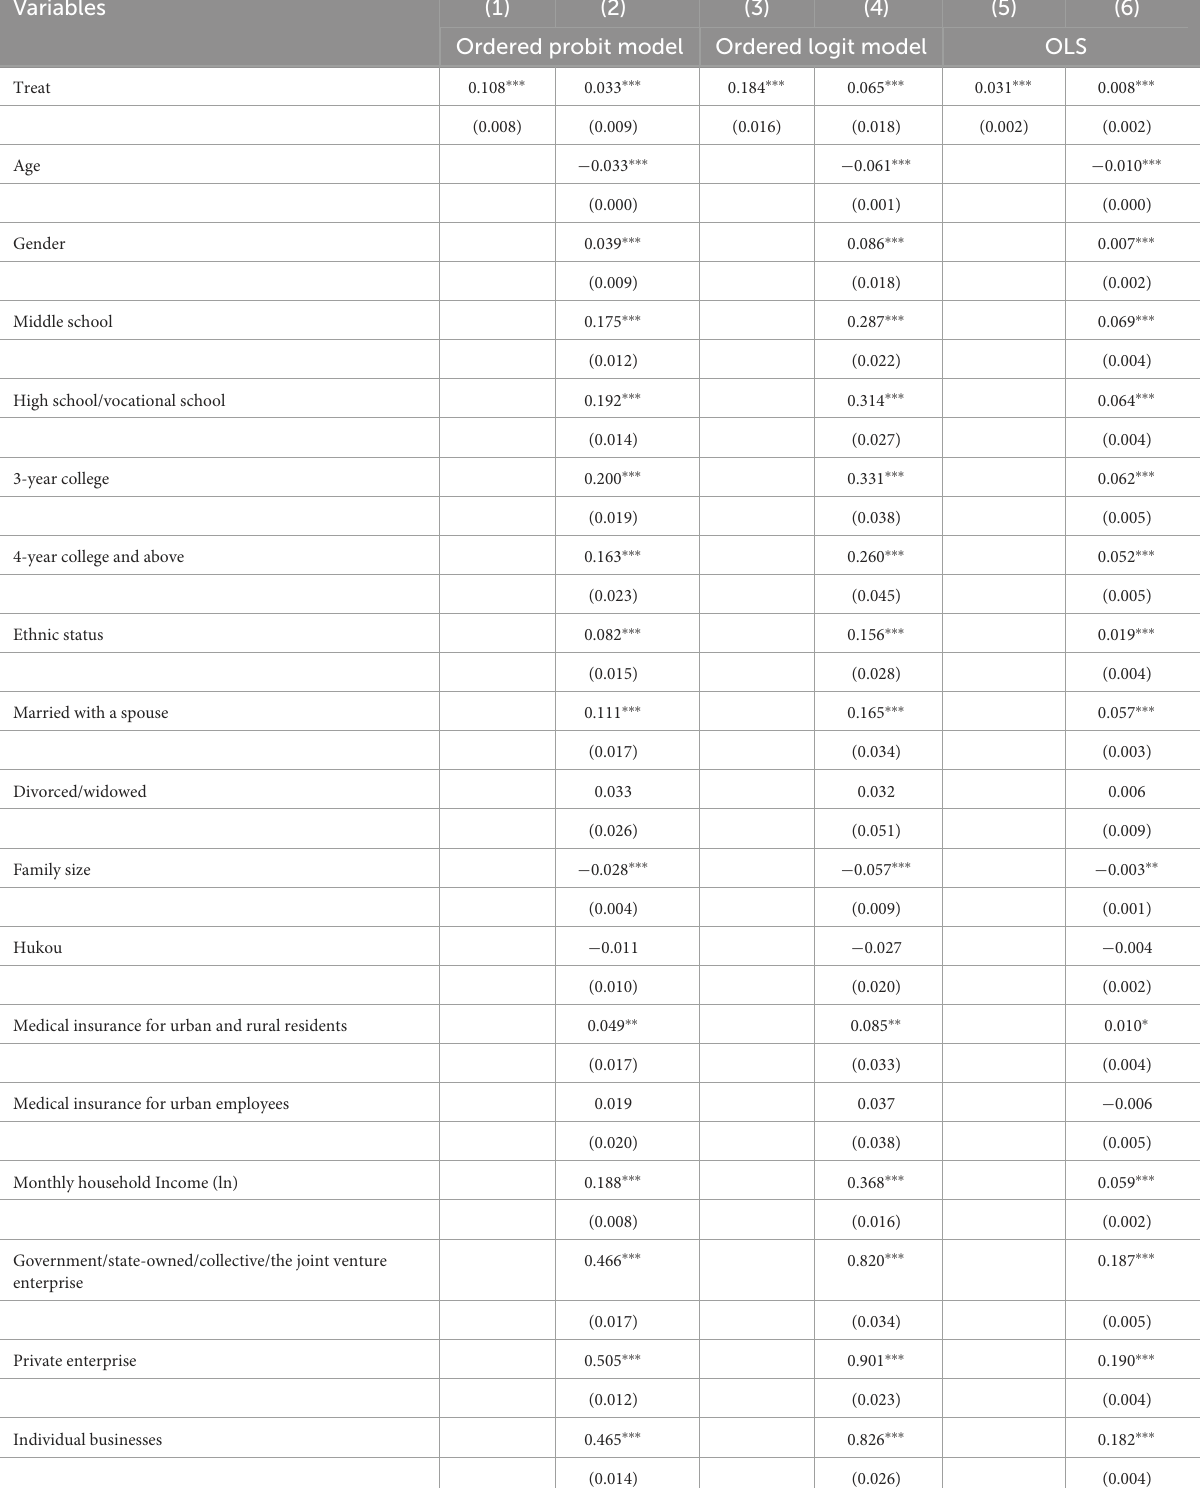
TABLE 3 The results for the effect of equalization of public health services on the health of the migrant population in China.